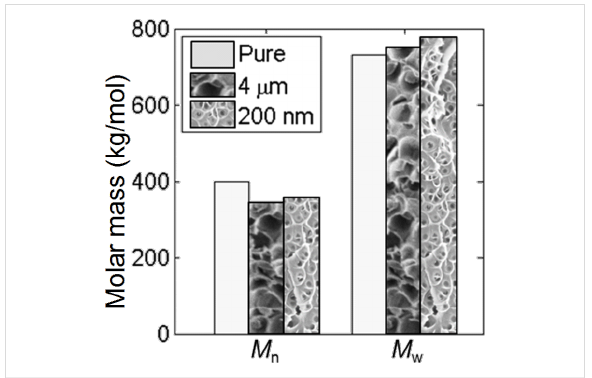
Figure 6: Change of the number- ( M n ) and mass- ( M w ) average of the molar mass in PMMA before and after foaming measured by size exclusion chromatography. The mean pore size is indicated in the legend. Decreasing M n values and increasing M w values suggest a shortening of PMMA macromolecules with lower molecular